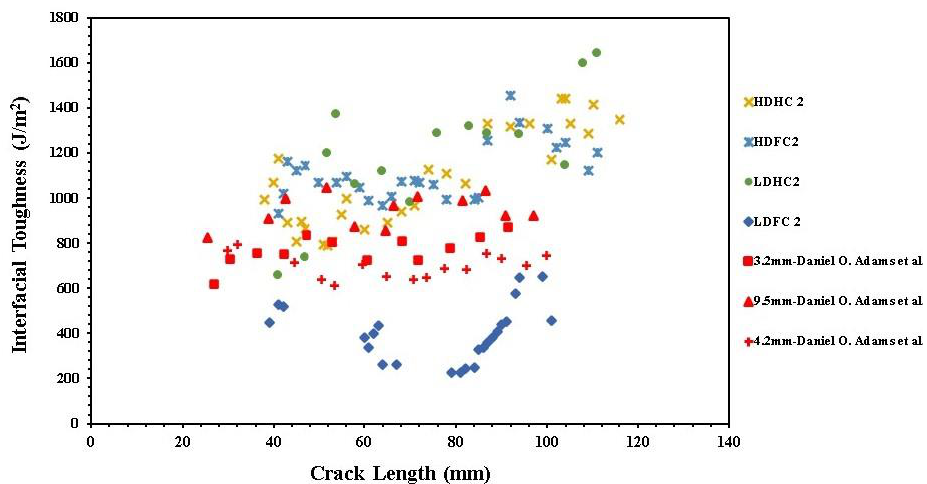
Figure 15. Comparison of the current interfacial toughness measurements with that of the Adams et al. [33] work.